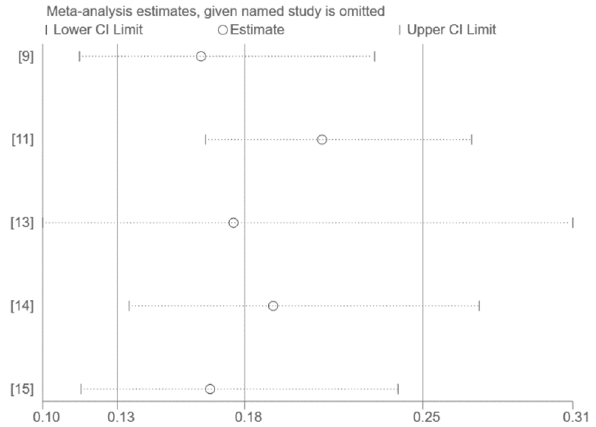
Figure 3. Sensitivity analysis (all publications) [9–15].